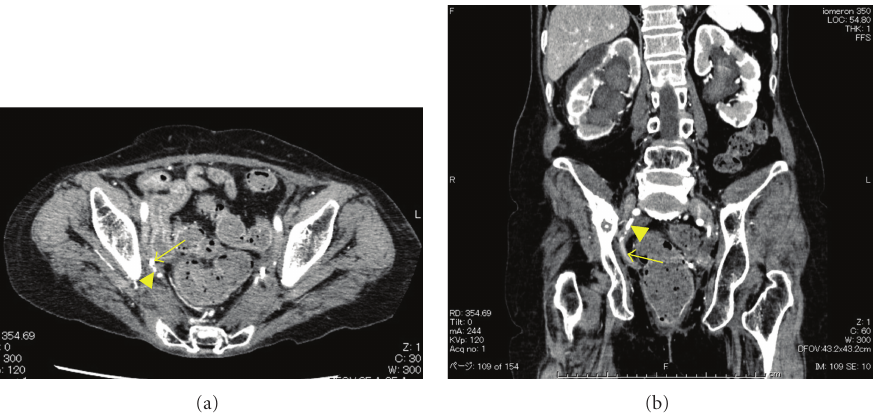
Figure 1: (a) Enhanced computed tomography scan showing the right ureter (arrow) and the right internal pudendal artery (arrowhead). (b) Three-dimensional computed tomography showing the right ureter (arrow) and the right internal pudendal artery (arrowhead).